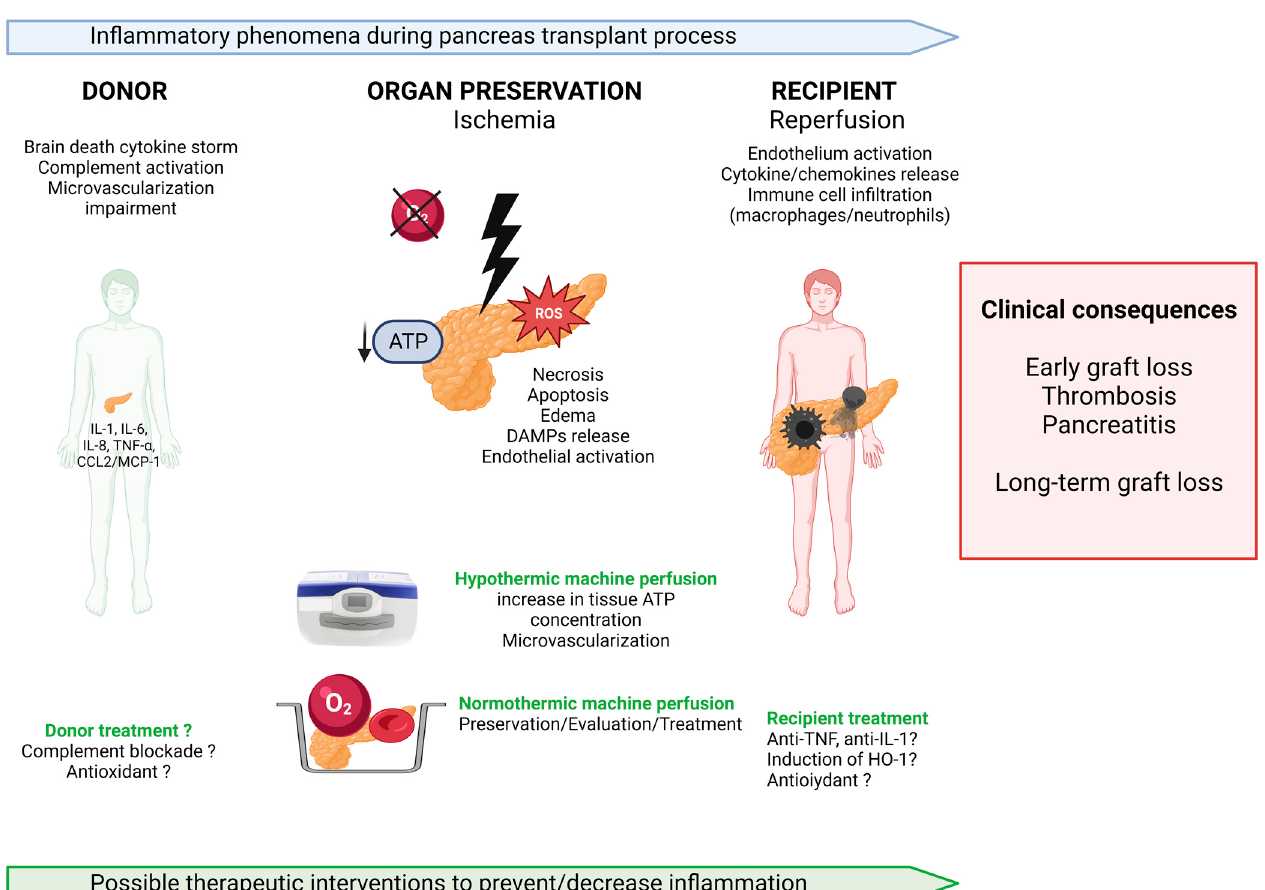
Figure 1. Inflammatory phenomena during pancreas transplantation and possible therapeutic interventions. IL interleukine, TNF tumor-necrosis factor, CCL2 chemokine ligand 2, MCP-1 monocyte chemoattractant protein 1, ATP adenosine tri-phosphate, ROS reactive oxygen species, HO-1 Heme oxygenase 1.